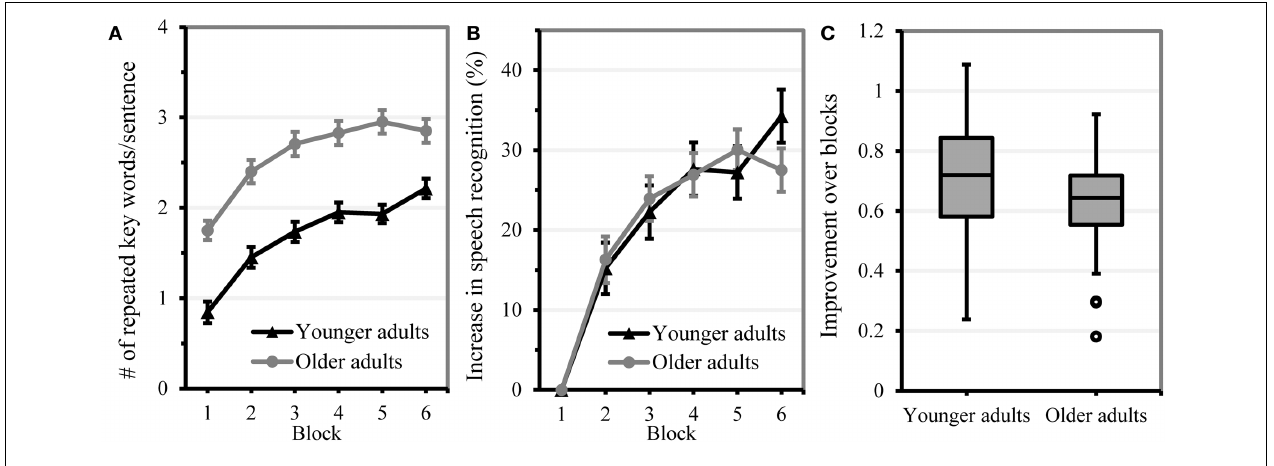
FIGURE 4 | Performance on the perceptual learning task. Error bars indicate two standard errors from the mean. (A) Mean improvement in speech understanding per age group over block. (B) Improvement in speech